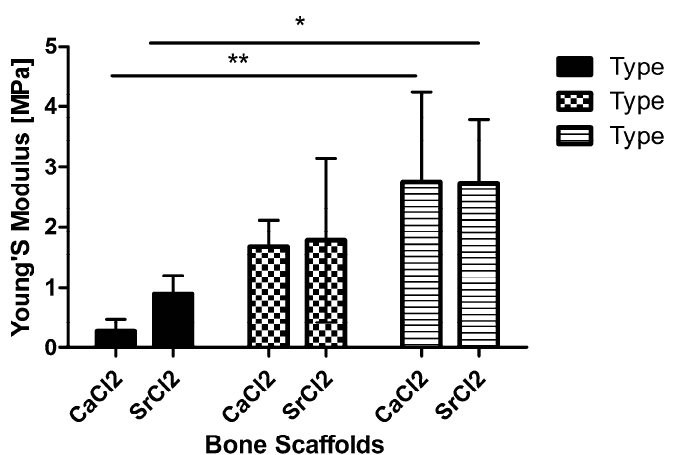
Figure 7. The material stiffness of the three types of bone scaffolds cross-linked with CaCl 2 and SrCl 2 . * p < 0.05 and ** p < 0.01.